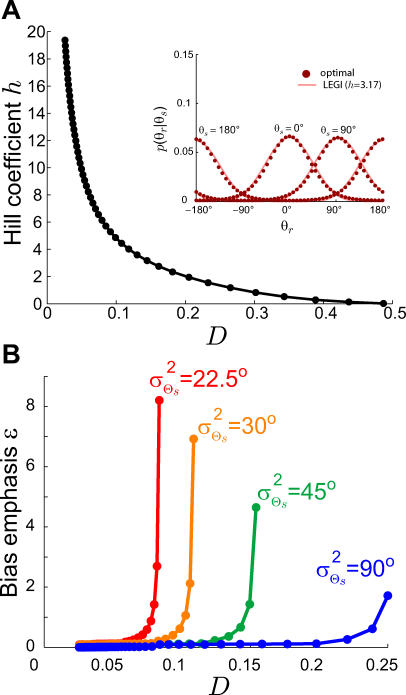
Optimal Model Parameters(A) Plotted is the Hill coefficient h that best fits the LEGI model to the optimal response function that achieves R(D) for Θs distributed uniformly and varying D. The optimal response for a distortion of D ≈ 0.15 is best fit by the LEGI model with a Hill coefficient of h ≈ 3.17 (inset), which is close to that observed in unpolarized D. discoideum cells (3.1 ± 0.89) and neutrophils (3.25 ± 2.0) [28,29].(B) The value of ɛ for which the response of the modified LEGI model matches the optimal response depends on the allowable distortion D and the gradient angle variance
. Larger ɛ (larger contribution of the internal bias signal b to the overall response) is required for smaller
and larger D. As in Figure 5, binding is excluded from the model response.